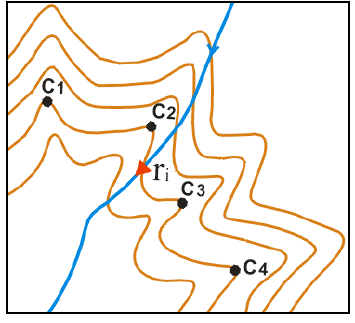
Figure 3. Building the matching relation